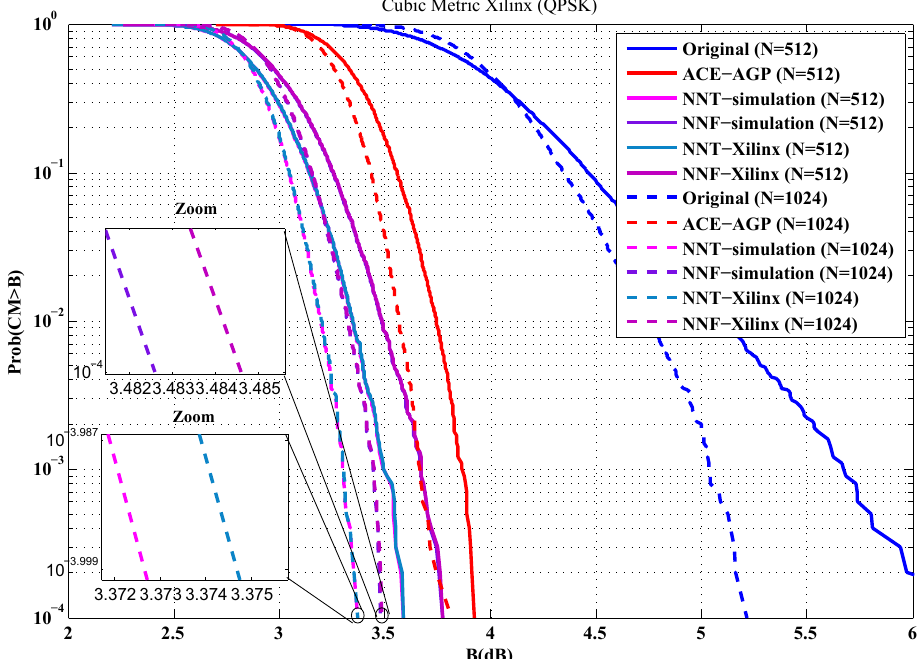
Figure 12. Cubic metric reduction in the case of QPSK modulation (Xilinx FPGA).